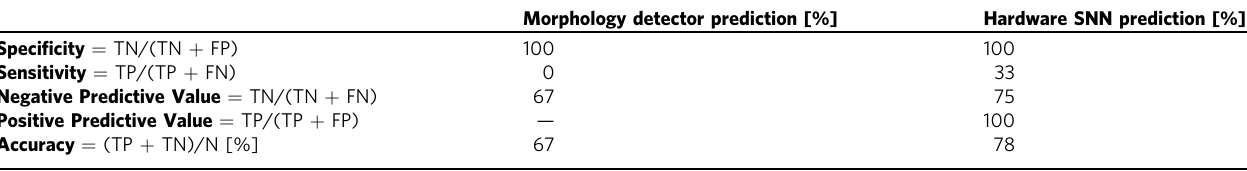
Table 2 Comparison of postsurgical outcome prediction between the Morphology Detector and our system. TP True Positive;